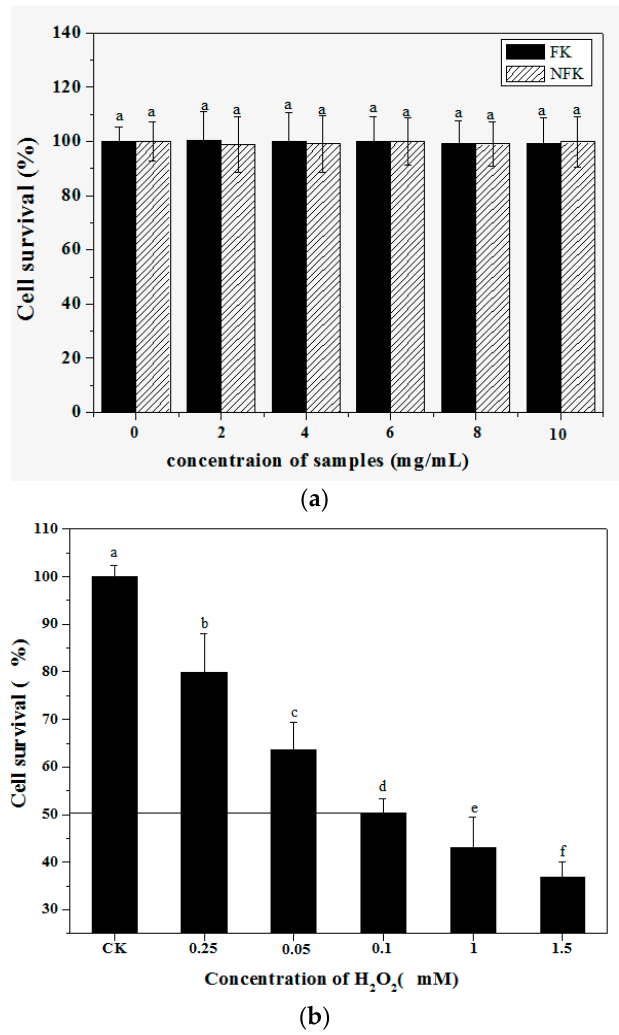
Figure 3. ( a ) The different concentration of NFK and FK on PC12 cells viability. Each value is expressed as the mean ± SD ( n = 3). In a column, the same superscript letters indicates that the difference between NFK and FK is not significant ( p > 0.05); ( b ) The oxidant model was evaluated by different concentration of H 2 O 2 on PC12 cells, which treated for 0.5 h exposed H 2 O 2 . Each value is expressed as the mean ± SD ( n = 3). Within a column, values with the different superscript letters are significantly different from each other at p < 0.05, line indicated the IC 50 value.